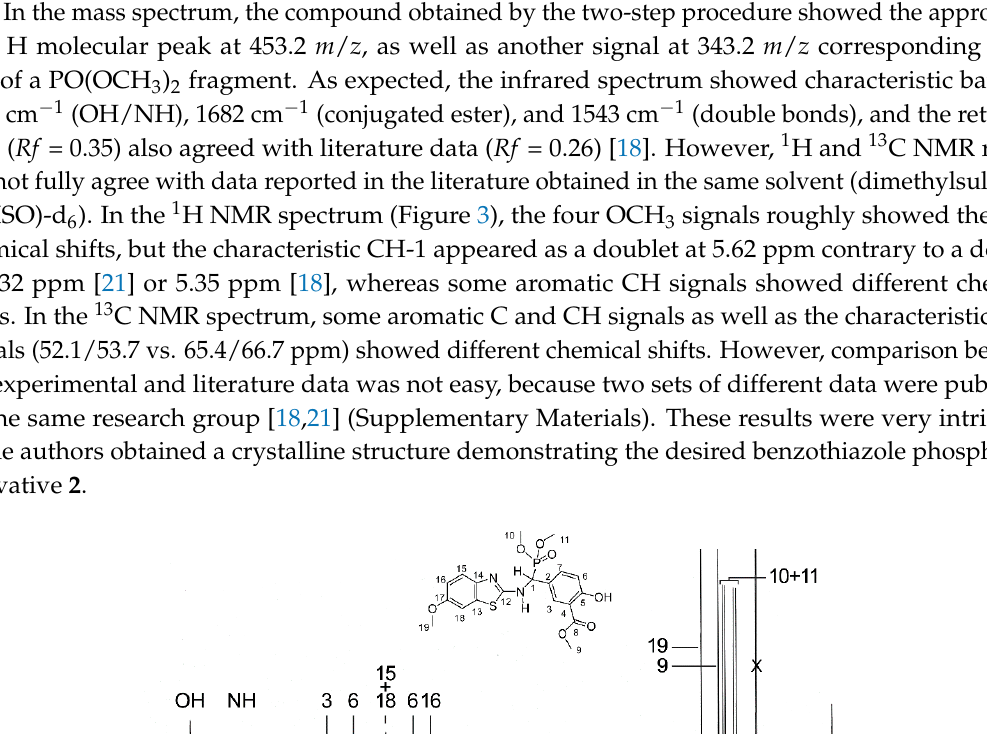
Figure 3. 1 H nuclear magnetic resonance (NMR) spectrum of compound 2 in dimethylsulfoxide (DMSO)-d 6 and full signal assignment.